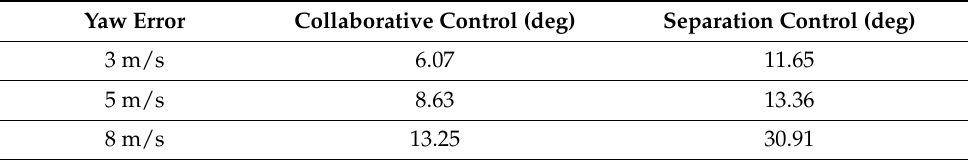
Table 3. Yaw error of the collaborative control and separation